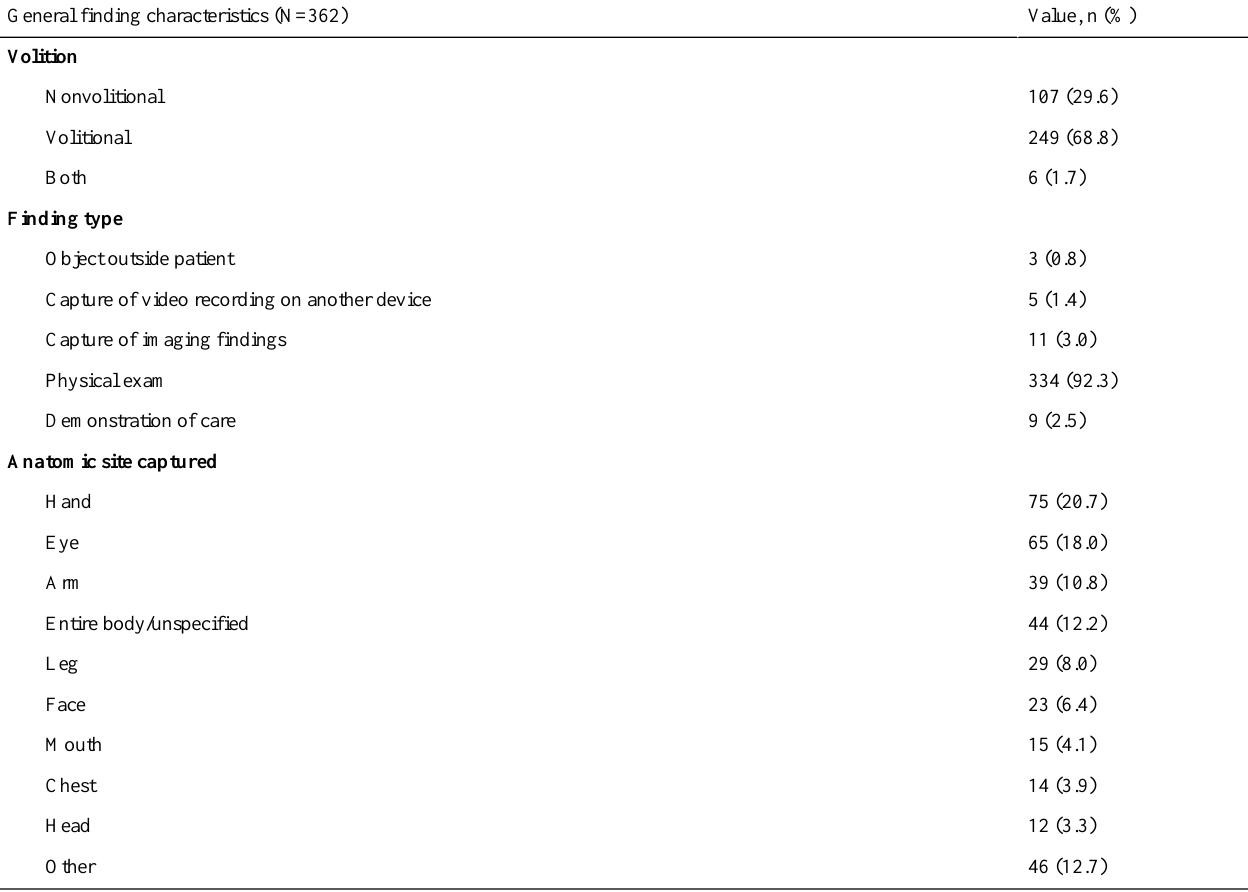
Table 4. General characteristics of the findings captured in